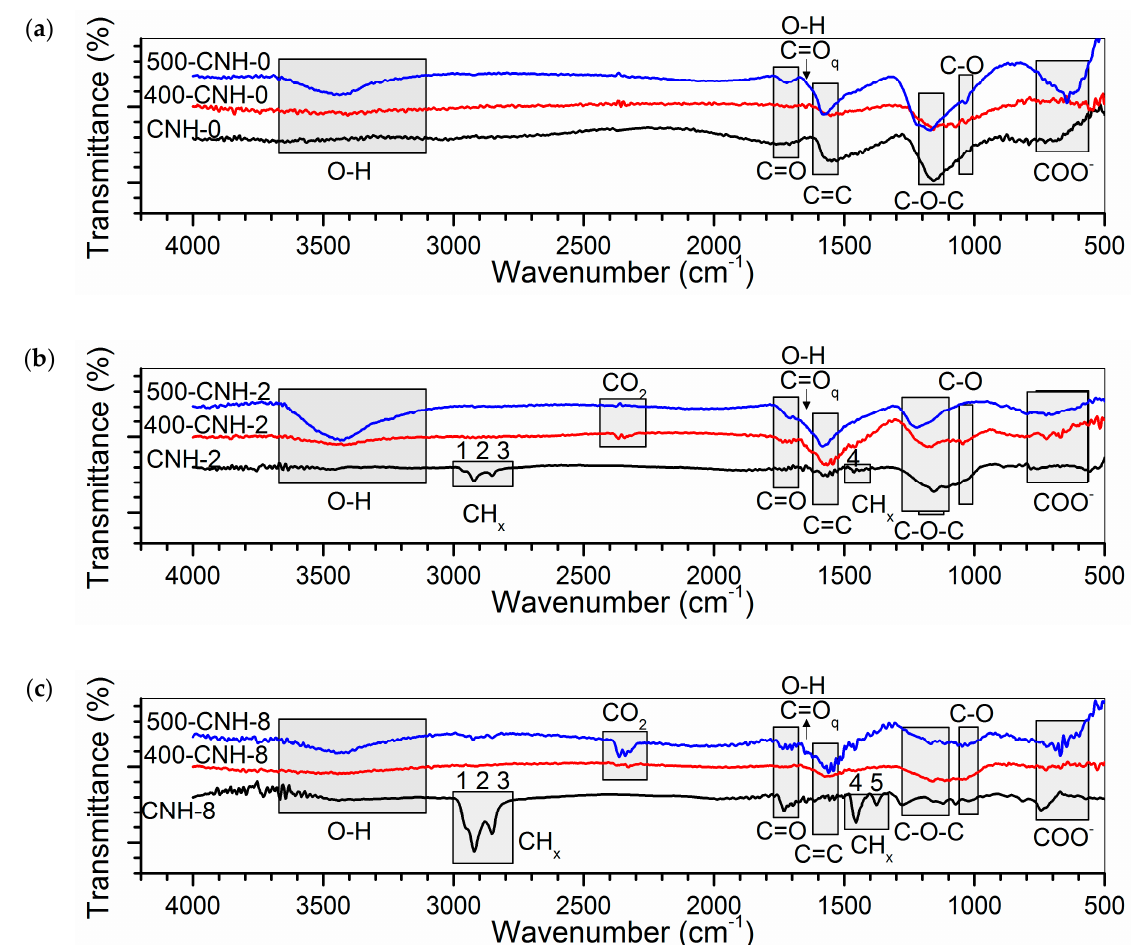
Figure 5. ( a – c ) IR spectra of initial and thermally oxidized CNHs. Peaks labeled as 1–5 are assigned to the following vibrations of − CH x groups: asymmetric vibration of CH 3 fragment (peak 1); asymmetric vibrations of CH 2 and CH fragments (peak 2); symmetric vibration of CH 2 fragment (peak 3); asymmetric bending of CH 3 fragment and the bending of CH 2 fragment (peak 4); symmetrical bending of CH 3 fragment (peak 5).